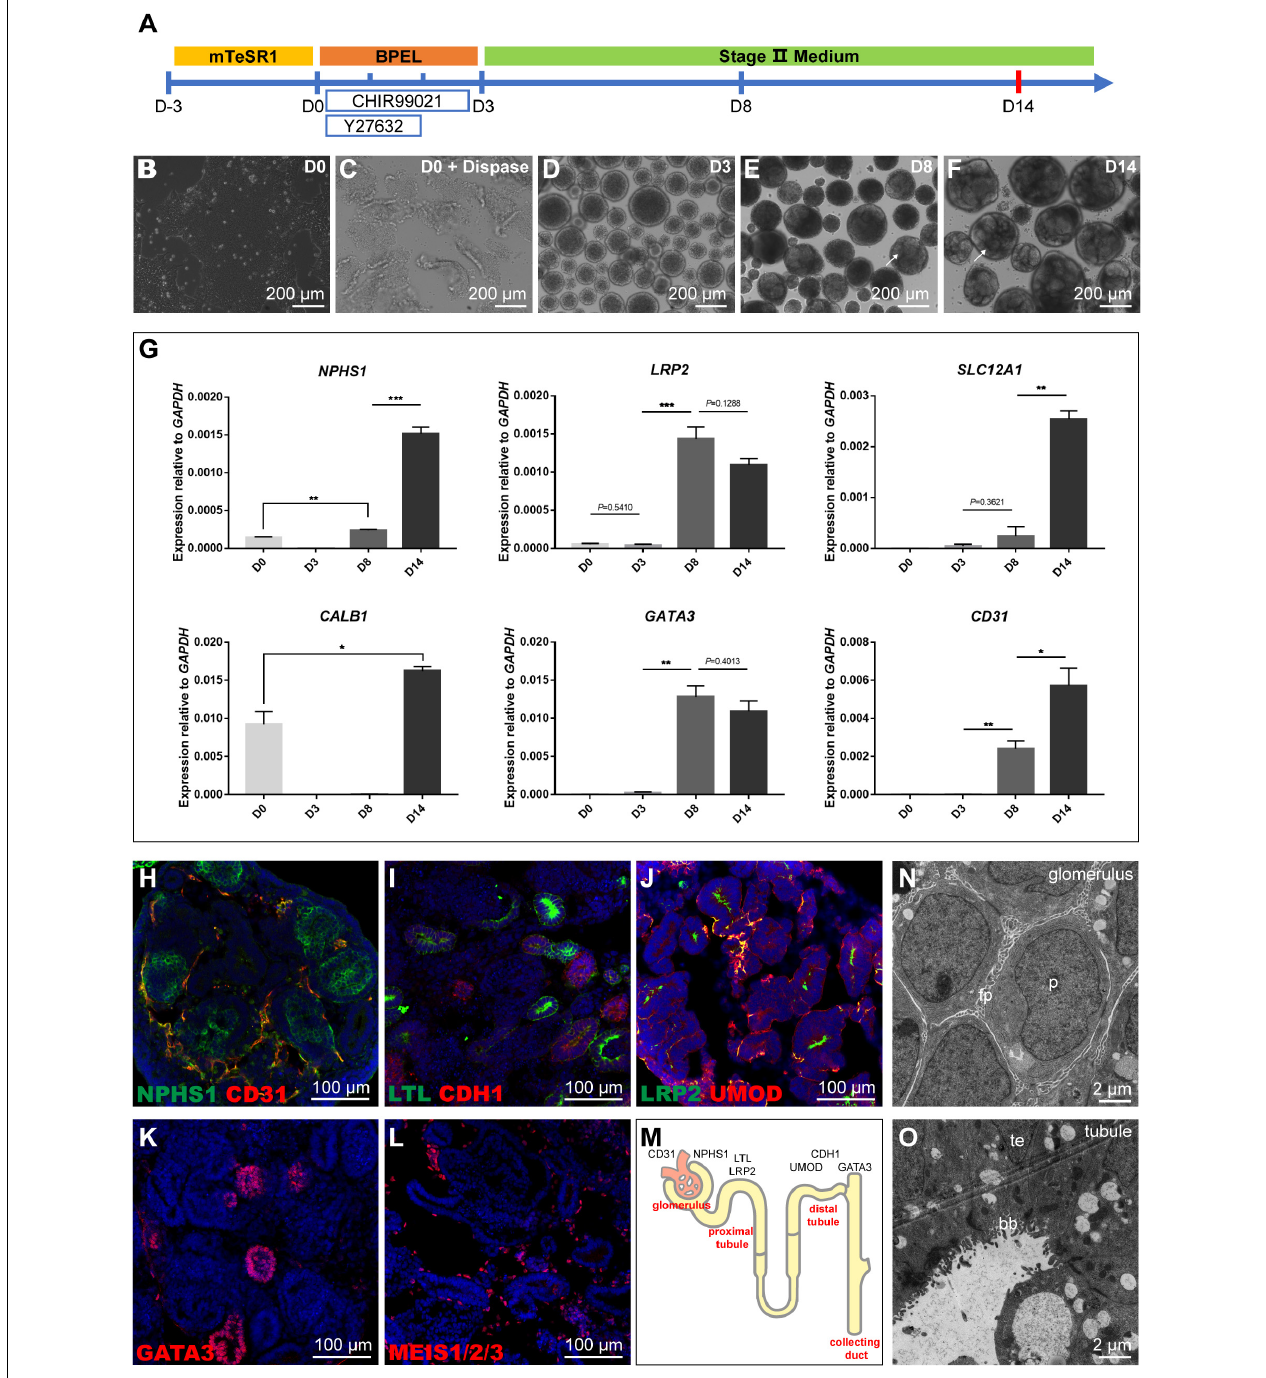
FIGURE 1 | Schematic representation and characterization of the kidney organoid differentiation process. (A) Roadmap of kidney organoids derived from hiPSCs. (B,C) Starting iPSC colonies and iPSC colonies digested by dispase. (D) Embryoid bodies. (E,F) The phenotype of kidney organoids at day 8 (D8) and day 14 (D14); formation of tubules is visible on the surface (arrows). (G) qRT-PCR analysis for selected markers during the differentiation at day 0, 3, 8, and 14. Data are presented as mean ± SEM from biological triplicates. ** P < 0.01, *** P < 0.001. (H–L) Immunostaining of frozen sections of day 14 organoids showing NPHS1+ podocytes and CD31+ endothelial cells, LTL+ proximal tubules, and CDH1+ distal tubules, LRP2+ proximal tubules, and UMOD+ thick ascending limb segments, GATA3+ collecting duct structures, and MEIS1/2/3+ interstitial cells. Nuclear counterstain: DAPI. (M) Schematic representation of kidney organoids (day 14). (N,O) Transmission electron micrograph (TEM) images of day 14 organoid sections: podocytes (p, podocytes; fp, primitive foot processes); and tubular (te, tubular epithelium; bb, brush border).